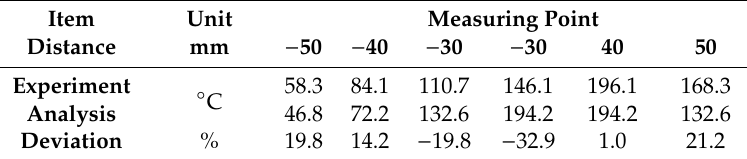
Table 7. Comparison of maximum displacements in y-direction [mm].